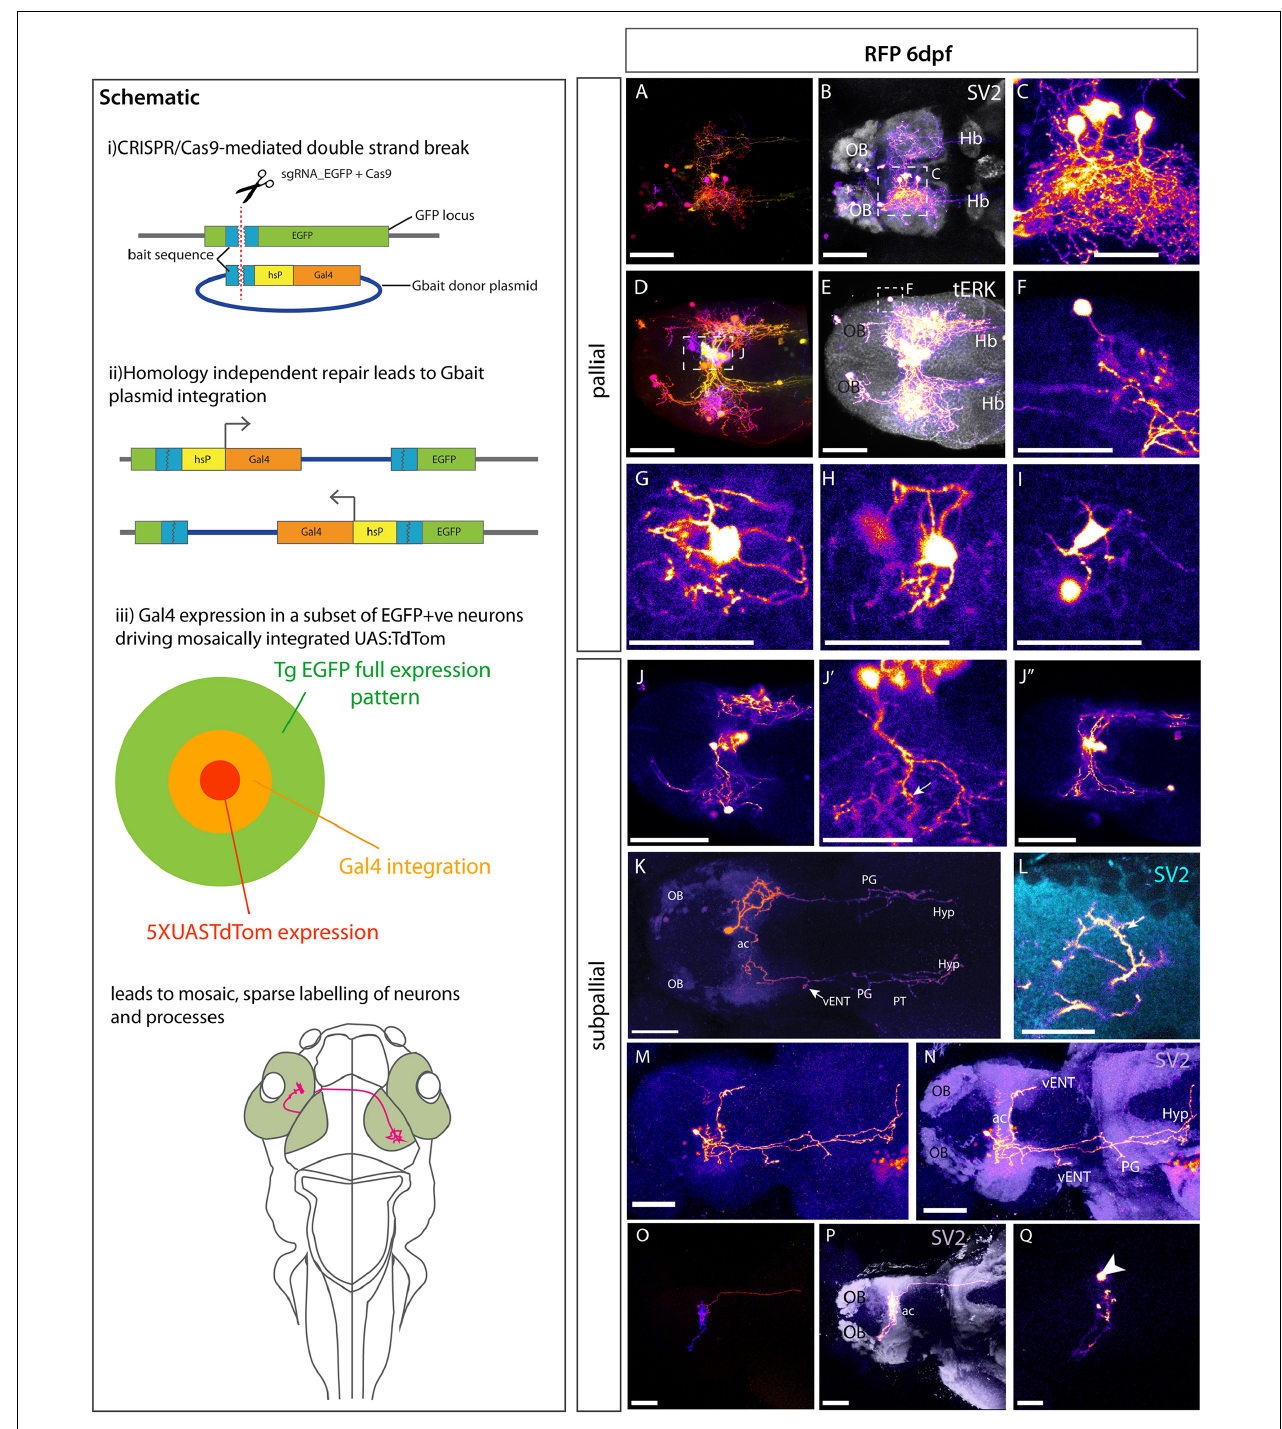
FIGURE 8 | Morphologies of pallial and subpallial neurons. Schematic: Schematic parts (i,ii) adapted from Kimura et al., 2014 explaining the Crispr/Cas9 mediated method to switch EGFP to Gal4. (iii) Shows our adaptation of this method to sparsely label single neurons and their processes by adding 5XUASTdTom to the injection mix. (A–Q) Et (gata2:EGFP) bi105 larvae injected with CRISPR cocktail and labeled with anti-RFP and other markers. (A–I) Pallial Neurons. (A–I) Dorsal views of 6dpf Et (gata2:EGFP) bi105 larvae injected with CRISPR cocktail. Labeled with anti-RFP (FIRE depth color code) (A,D) and FIRE LUT (B,C,E,F) , anti-SV2 (gray) (B) , anti-tERK (gray) (E) . (C) Detail of “monopolar” dorsal pallial neurons from larva shown in panel (A , B) [area indicated by whisker box in panel (B) ]. (F) Detail of single monopolar pallial neuron from larva shown in panels (D,E) [area indicated by whisker box in panel (E) ]. (G–I) Three examples of basket shaped cells all found in the dorsal pallium of larva shown in panels (D,E) . (J–Q) : Subpallial neurons. (J–J (cid:48)(cid:48) ) A cluster of midline subpallial cells from larva shown in panels (D,E) exhibiting